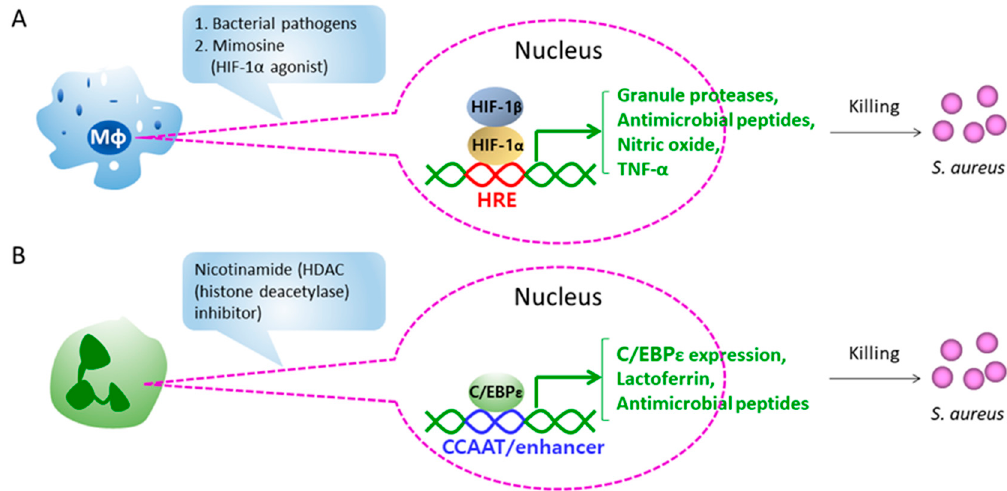
Figure 3. Immune-based strategies targeting regulators. ( A ) HIF-1 α is activated on exposure to bacterial pathogens and induces the production of granule proteases, antimicrobial peptides, nitric oxide, and TNF- α in host phagocytes, suggesting HIF-1 α as a therapeutic target for enhancing host defense. HIF-1 α agonist mimosine pharmacologically augments antimicrobial capacity of human phagocytes and whole blood to kill S. aureus. ( B ) HDAC inhibitor nicotinamide enhances mRNA and protein levels of C/EBP ε and several downstream effector molecules such as antimicrobial peptides and proteins in